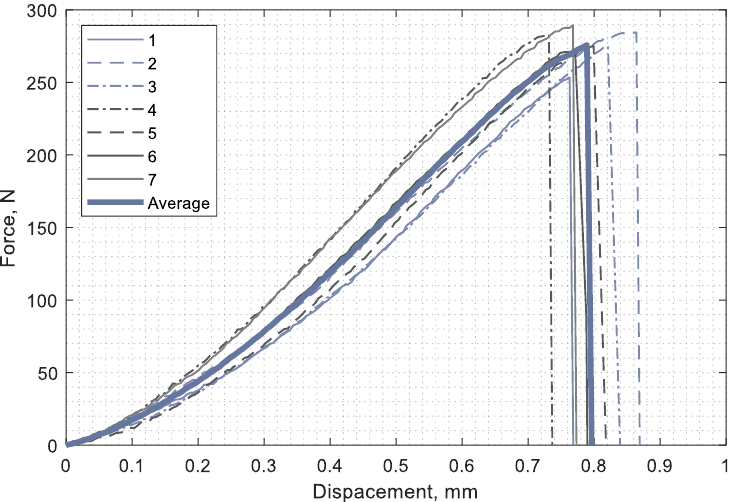
Figure 13. Force-displacement curves for single specimen 1 to 7 as well as averaged.